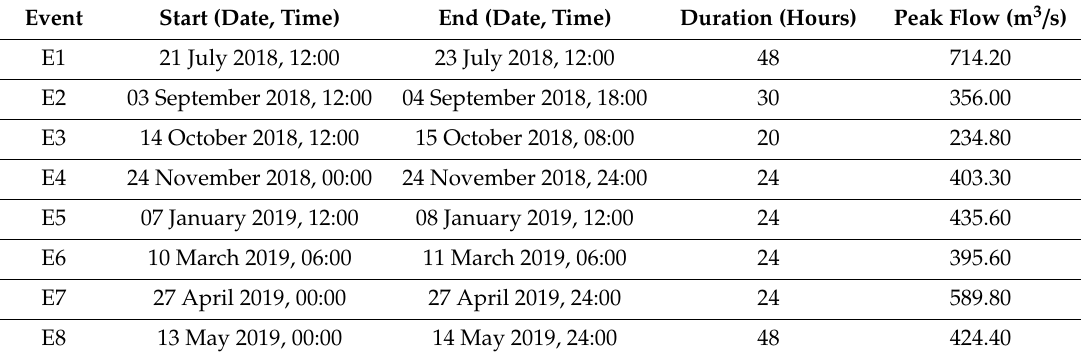
Figure 2. Time series of precipitation (P) and streamflow (Q) from July 2018 to May 2019. The orange dashed line represents the 211 m 3 /s threshold for storm event selection. Table 2. Duration and peak flow of the eight storm events considered for model calibration and validation.